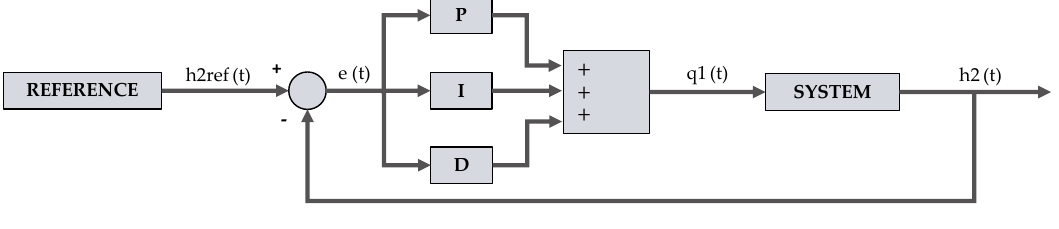
Figure 2. Control schema: PID